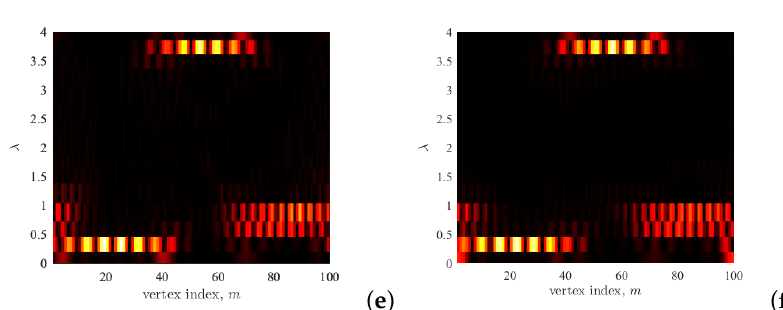
Figure 10. Time–frequency representation of a three-component time-domain signal from Example 1, shown in Figure 3 (top), based on various transfer functions from Figure 5. The LGFT is calculated based on: ( a ) the transfer functions in Figure 5, ( b ) the transfer functions in Figure 9a, ( c ) the wavelet- like spectral transfer functions in Figure 9b, ( d ) the signal adaptive transfer functions from Figure 9b, ( e ) Chebyshev polynomial-based approximations from Figure 9d, with M = 20 and ( f ) Chebyshev polynomial-based approximations from Figure 9d, with M = 50.